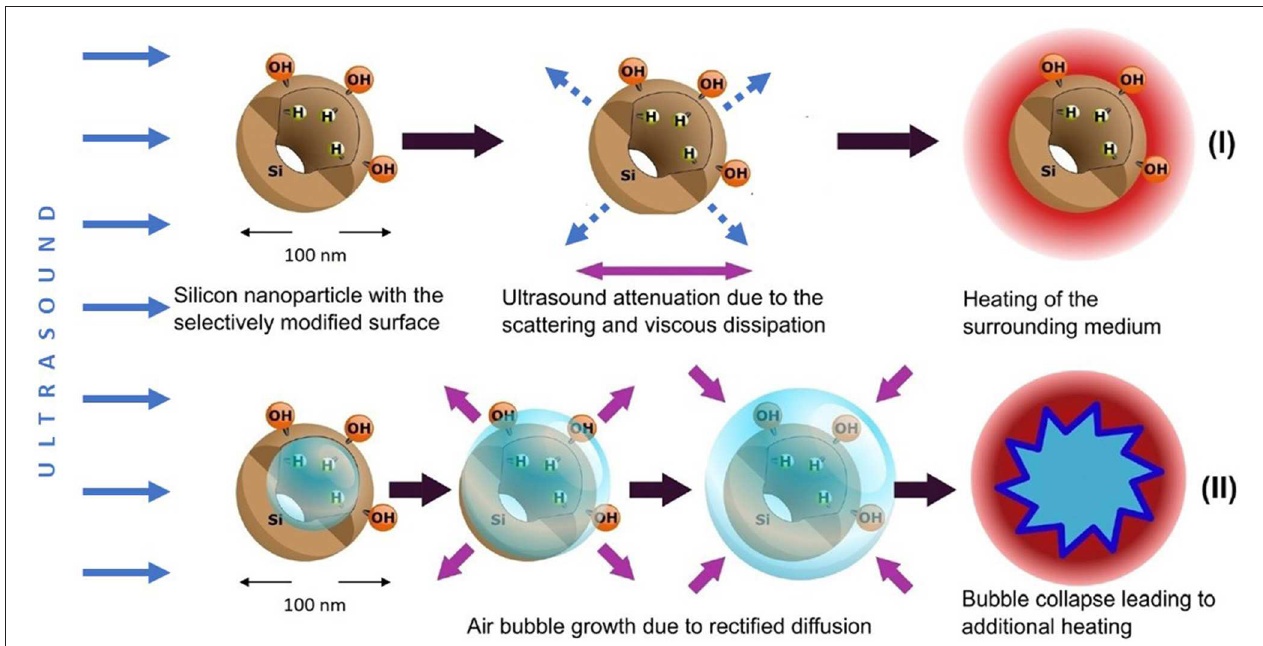
FIGURE 8 | Two mechanisms of the dissipation of US energy in aqueous suspensions of O-PSi NPs and J-PSi NPs: (I) enhanced scattering of US waves and viscous dissipation of the US energy, which takes place for both types of the suspensions; (II) acoustic cavitation leading to the high-energy bubble collapse and additional heating, which is most pronounced in case of J-PSi NPs with hydrophobic inner walls. Blue solid arrows indicate energy flow vectors of the incident ultrasound beam, dashed arrows correspond to the waves scattered by PSi NPs. Violet arrows depict the process of viscous friction and air bubble